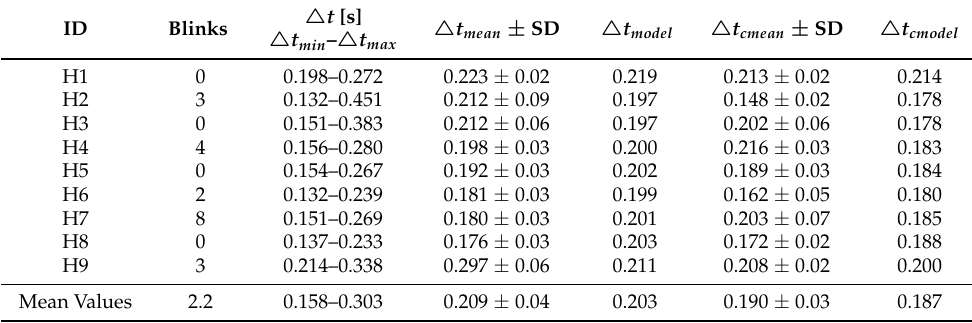
Table 5. Visually guided saccade test: latencies values for the control group.